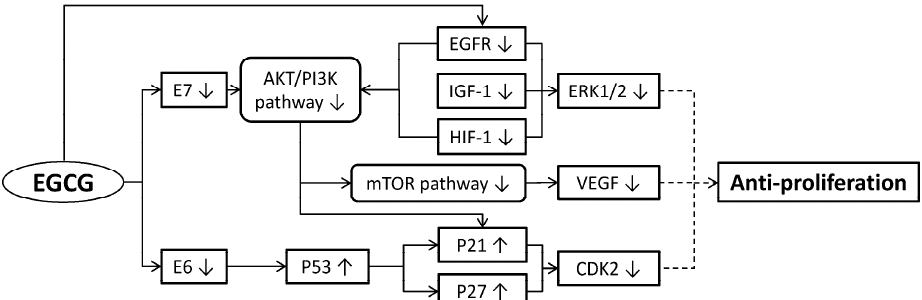
Figure 1. Molecular mechanisms of (-)-epigallocatechingallate (EGCG) suppressing the proliferation of cervical cancer cells. EGCG down-regulated the expressions of E6, E7, EGFR, IGF-1 and HIF-1, then the expressions of downstream targets such as the AKT/PI3K pathway, mTOR pathway and ERK1/2 also declined. The decline of E6 could up-regulated P53 expression resulting in P21 and P27 up-regulations, then CDK2 was down-regulated. The down-regulation of the mTOR pathway led to VEGF reduction. Eventually, the reduced expressions of ERK1/2, VEGF and CDK2 suppressed the proliferation of cervical cancer cells (broken lines mean indirect approaches). AKT: protein kinase B; CDK2: cyclin-dependent kinase 2; E6: one of human papillomavirus (HPV) oncogenes; E7: another HPV oncogene; EGFR: epidermal growth factor receptor; ERK: extracellular signal-regulated kinase; HIF-1: hypoxia-inducible factor 1; IGF-1: insulin-like growth factor 1; mTOR: mammalian target of rapamycin; P21: tumor suppressor protein; P27: tumor suppressor protein; P53: tumor suppressor protein; PI3K: phosphoinositide-3-kinase; VEGF: vascular endothelial growth